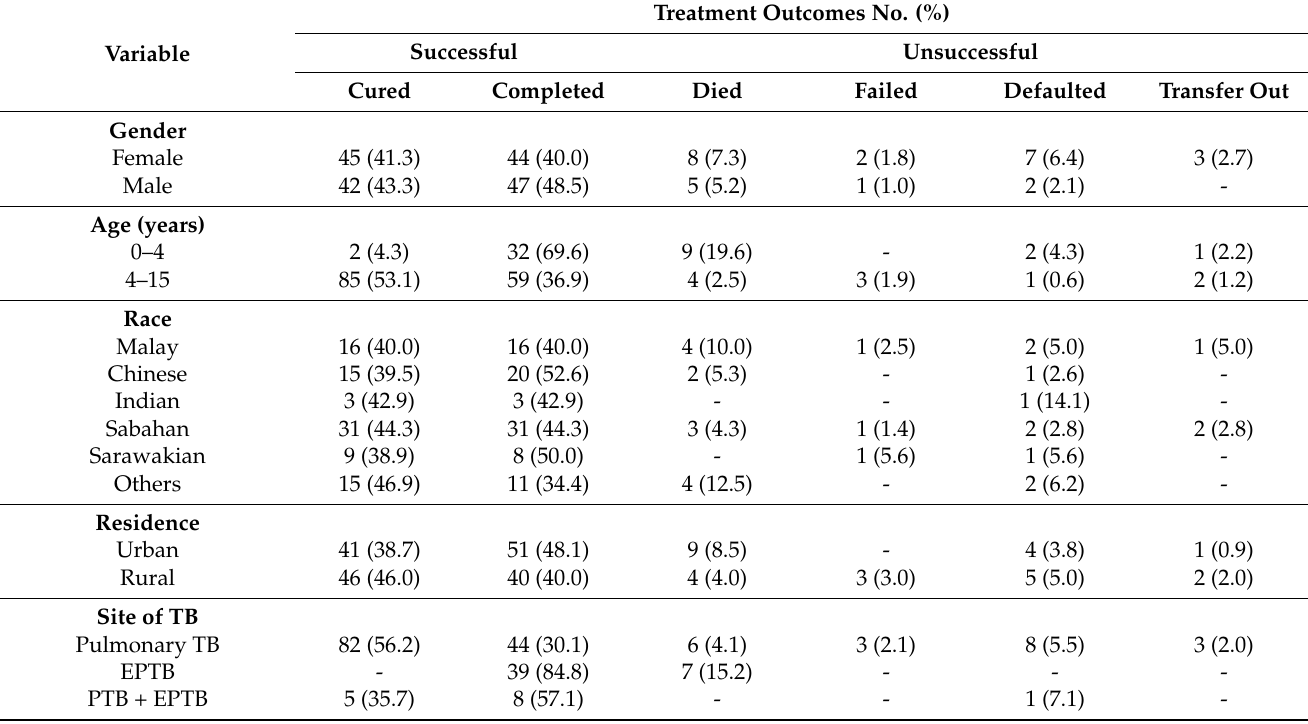
Table 2. Treatment outcomes of study